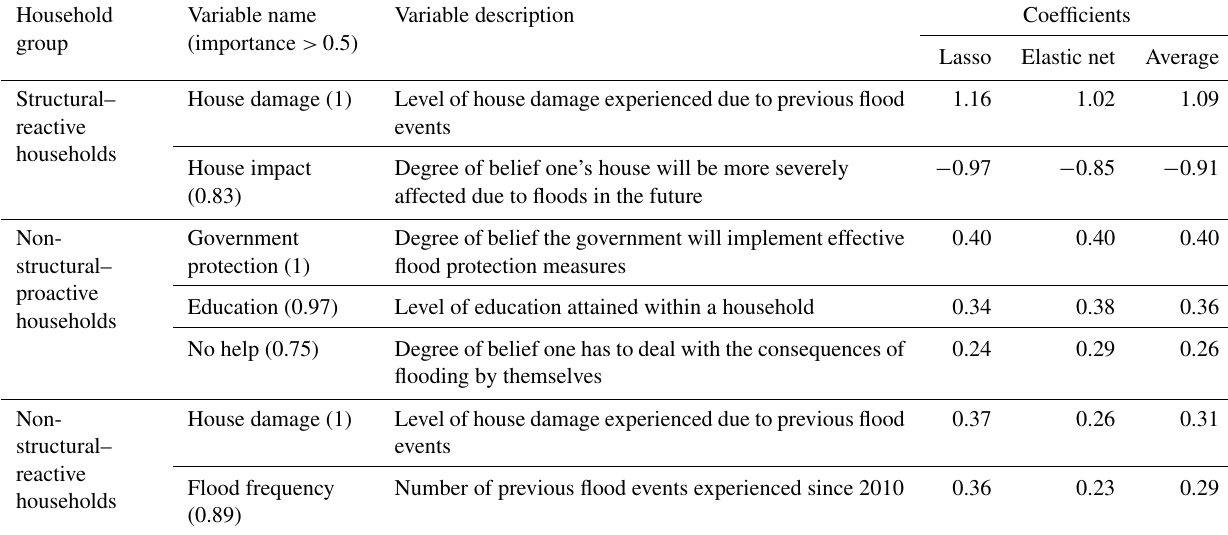
Table 3. Most important variables influencing implementation of precautionary measures (importance: 0 – no importance, 1 – high impor- tance; coefficients: positive – encourages the uptake of measures, negative – discourages the uptake of measures). All the models resulted in a deviance of approximately